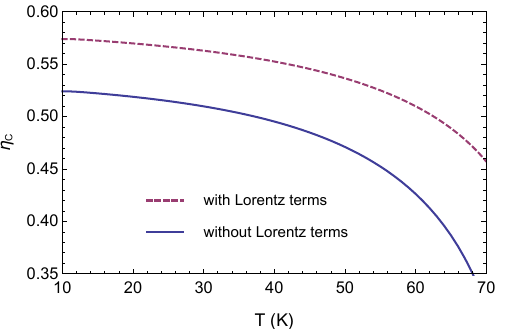
Figure 6. Comparison between normalized Casimir force acting on the superconductive plates with and without terms based on the Lorentz